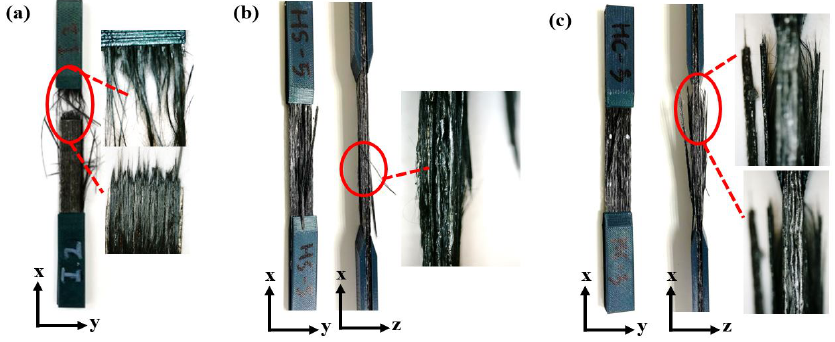
Figure 8. Fractured samples after performing tensile testing. ( a ) Intact; ( b ) continuous; ( c ) cyclic.